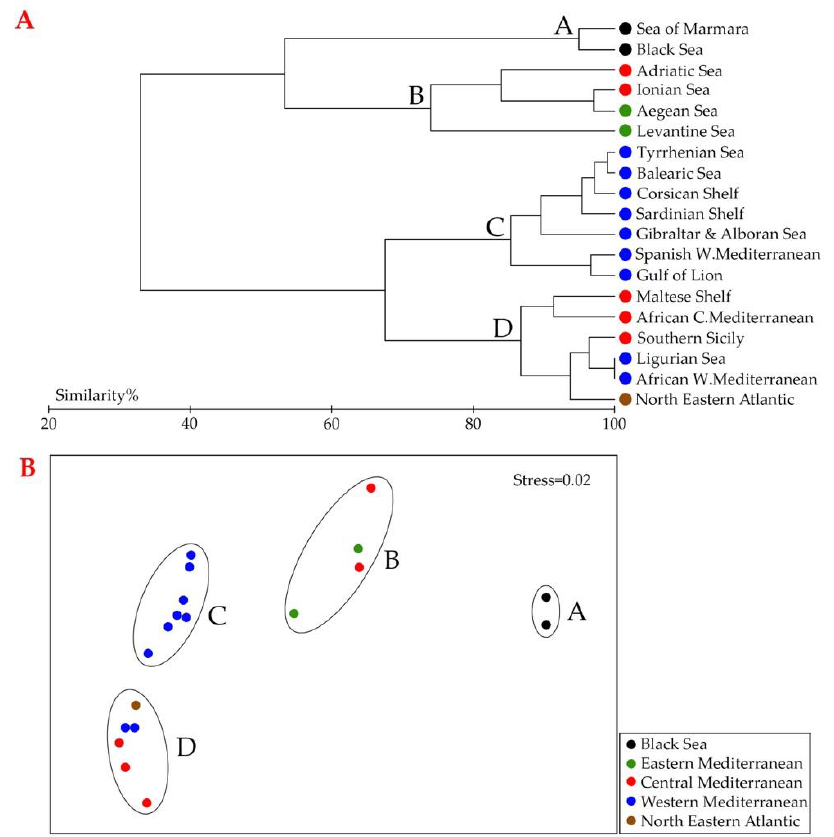
Figure 6. Grouping of records of G. incognitus and G. bucchichi based on their greographical coordinates. Dendrogram ( A ) and non-metric multidimensional scaling (nMDS) ordination ( B ), indicating the groupings obtained from the cluster analysis.